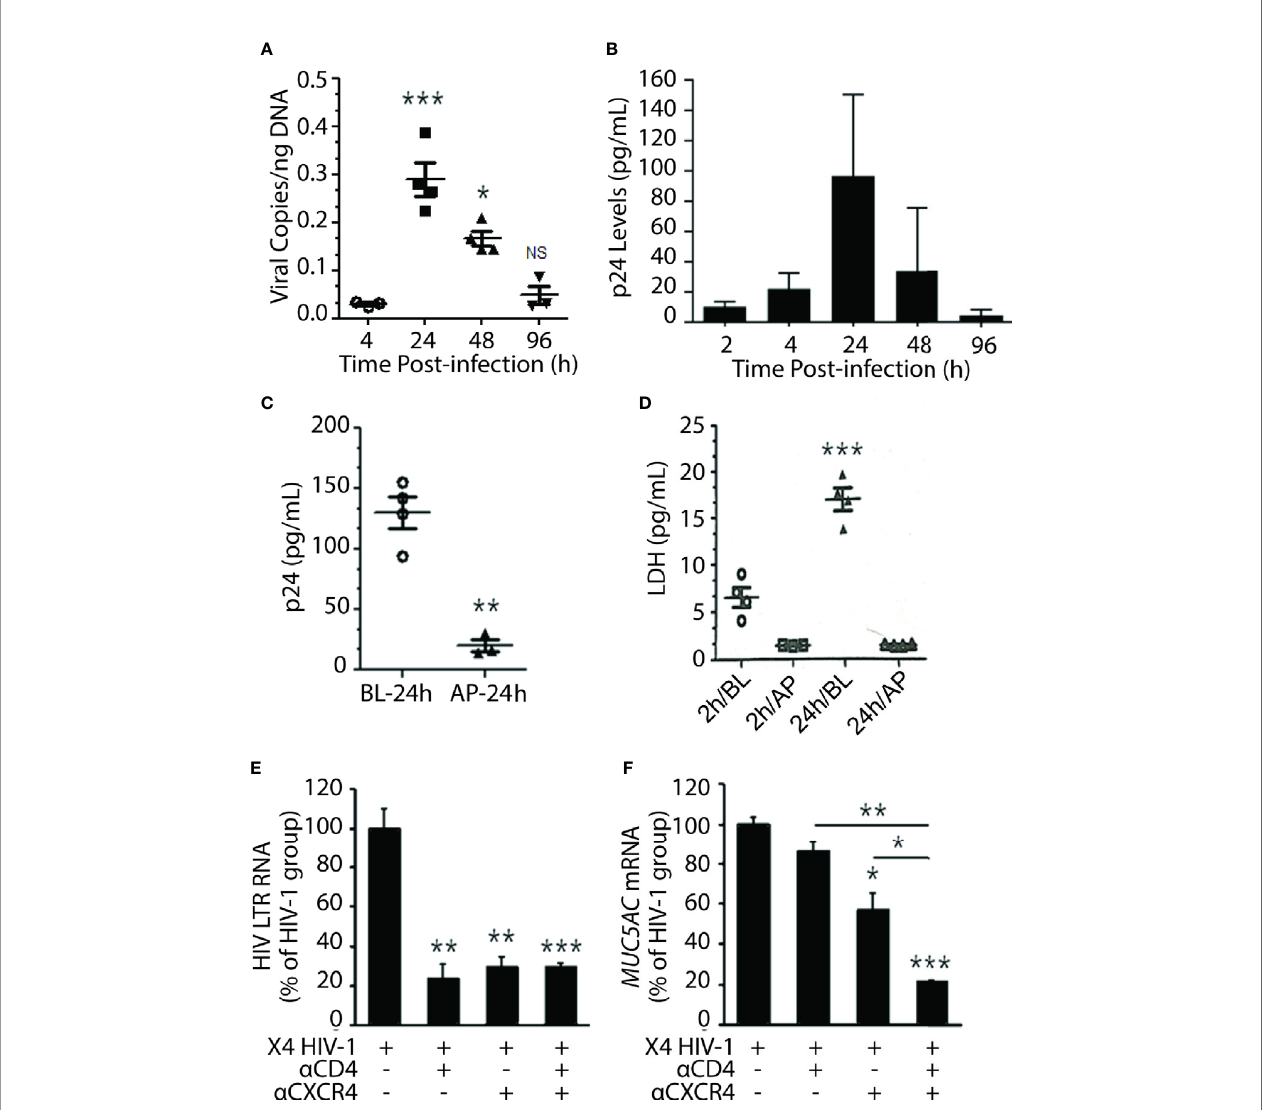
FIGURE 2 | Differentiated NHBE cells were infected by X4-tropic HIV-1 and blocking HIV-coreceptors inhibits HIV infectivity. (A) Expression kinetics of HIV-1 gag DNA levels (viral copies per ng of cellular DNA) in NHBE cell lysates analyzed at 2, 4, 24, 48, and 96 h post X4-tropic HIV-1 LAV infection. (B) Expression kinetics of p24 (pg/ml) measured in cell culture media collected from the bottom of transwells at the denoted time post infection. (C) HIV-1 p24 levels at 24 h post-infection in NHBEs that were infected via basolateral (BL) or apical (AP) surfaces; and (D) LDH release quanti fi cation at 2 and 24 h post-infection in BL- or AP-infected cells. Relative quantities of (E) HIV-1 LTR RNA levels and (F) MUC5AC mRNA levels in NHBE cells pre-treated with either anti-CD4 or anti-CXCR4 antibodies followed by infection with X4-tropic HIV-1 LAV and 48 h post- infection cells were harvested and analyzed. Data shown as mean ± SEM; n = 3/group; *p < 0.05; **p < 0.01; ***p <